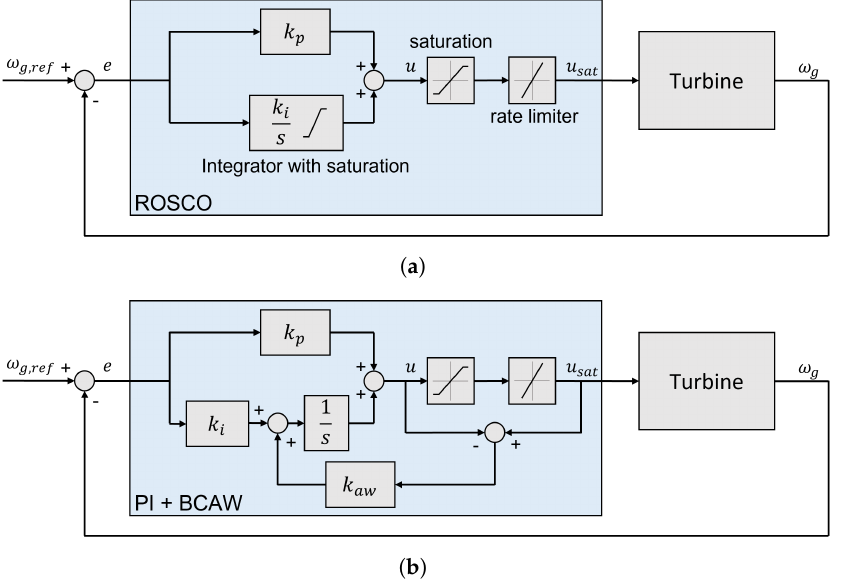
Figure 7. ( a ) Block diagram of the PI controller in ROSCO. ( b ) Block diagram of the PI controller with back calculation